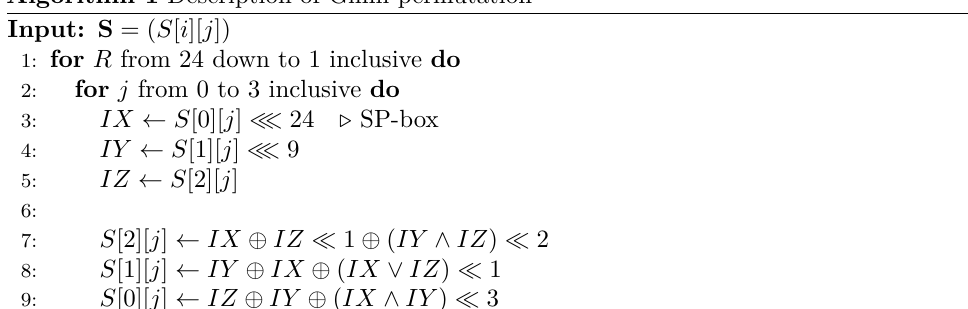
Algorithm 1 Description of Gimli